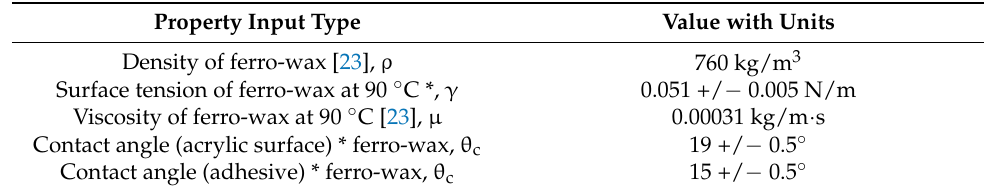
Table 1. Properties of ferrowax used in the ANSYS simulation.